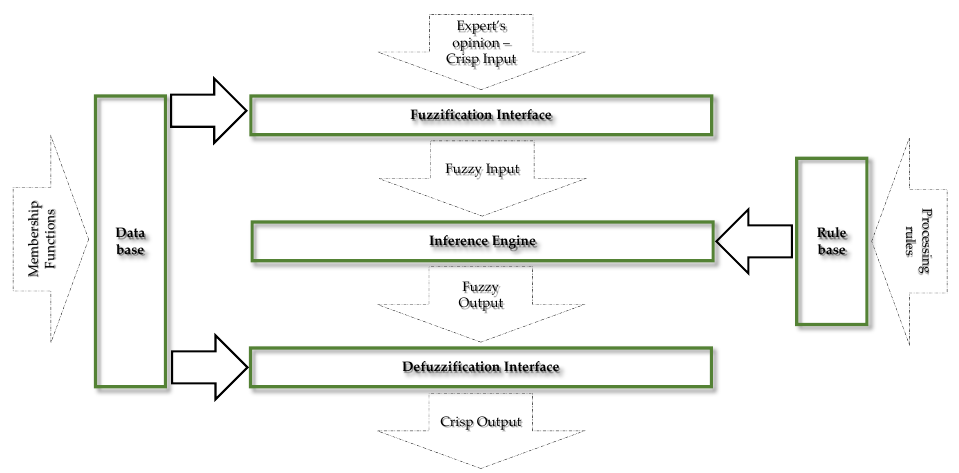
Figure 5. Algorithm for solving a research problem.